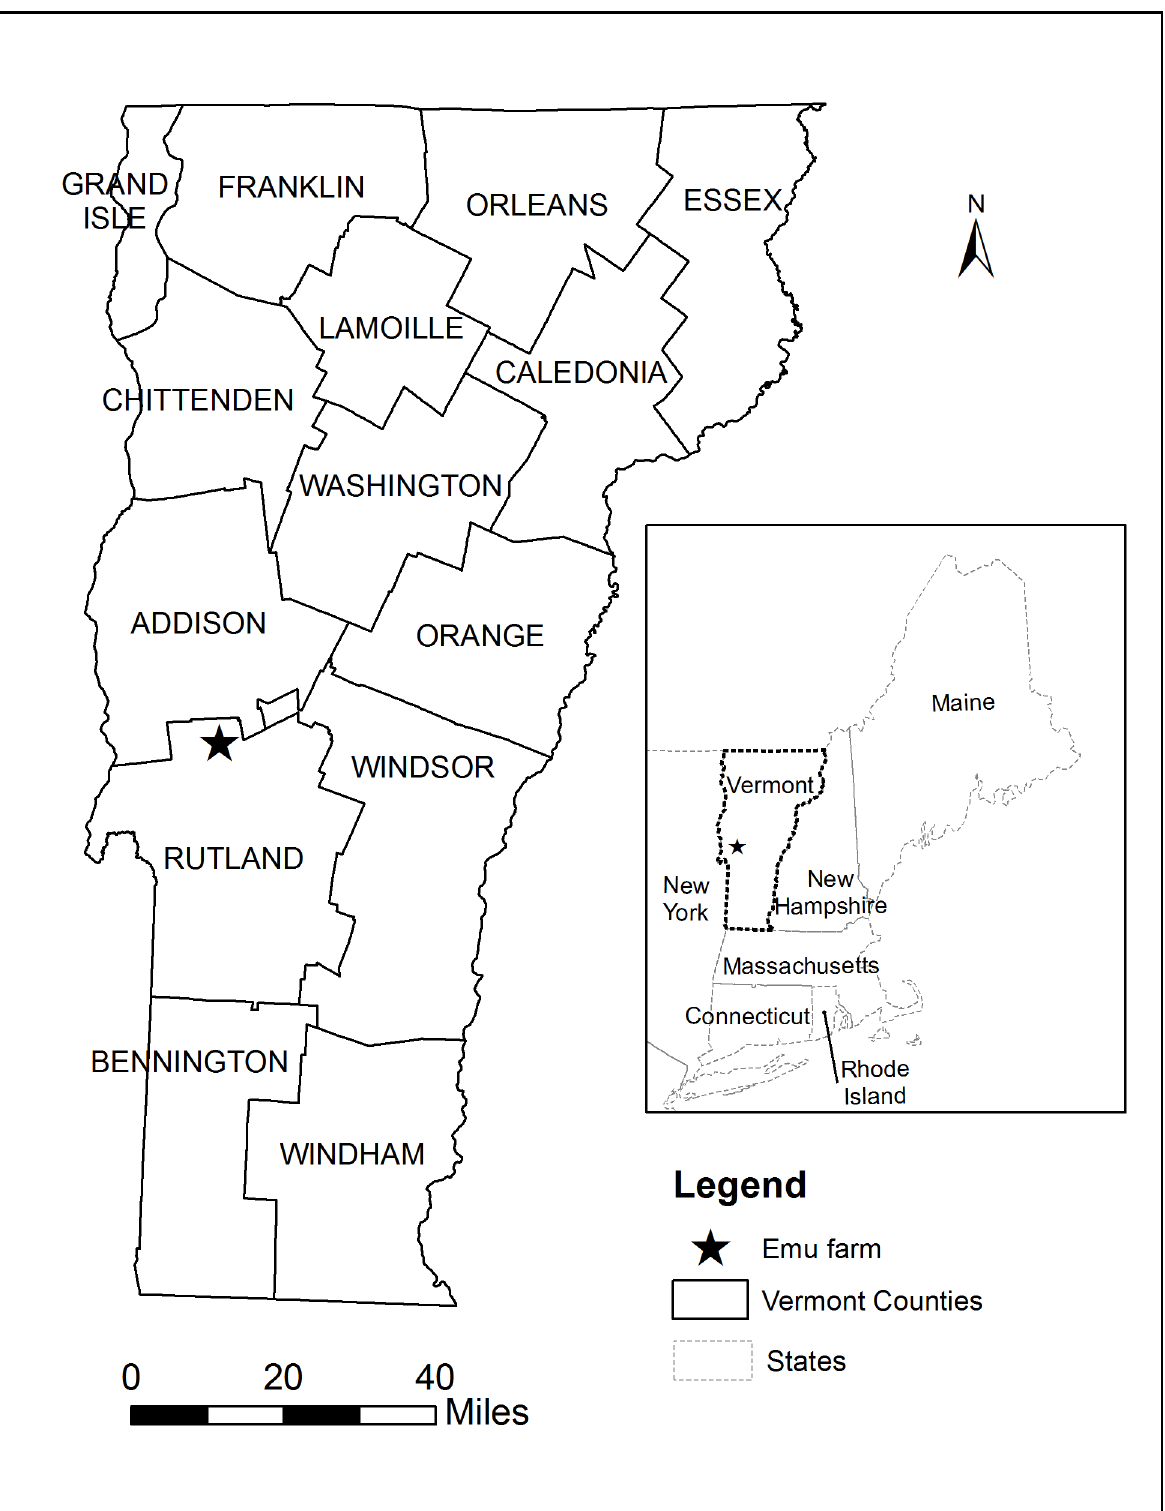
Fig 1. A map of Vermont showing the location of the emu farm in Rutland County where the EEE outbreak occurred in 2011.